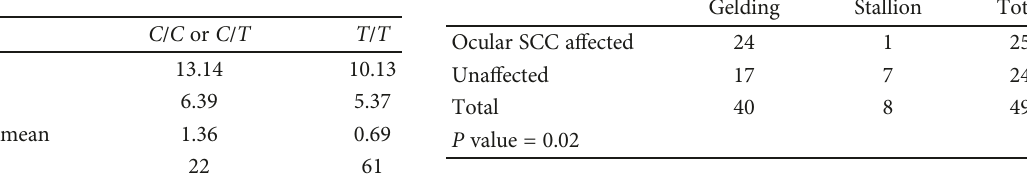
Table 3: Comparison of mean age of ocular SCC diagnosis in Ha fl ingers and Belgians ( n = 83 ) with respect to DDB2 c.1013 C > T genotypes.